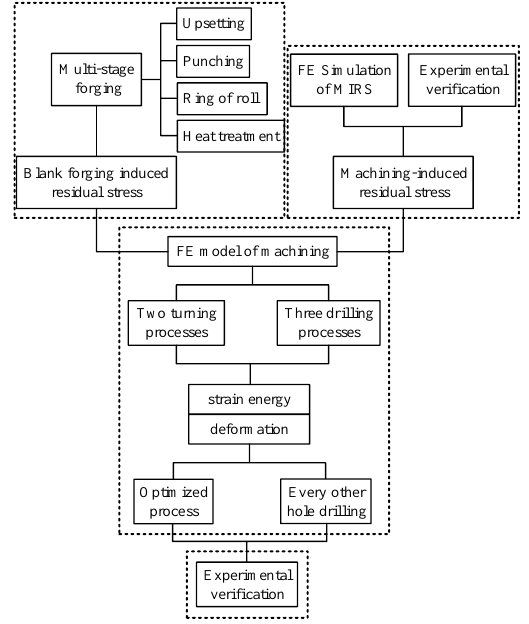
Figure 1. Flow chart of the methodology.